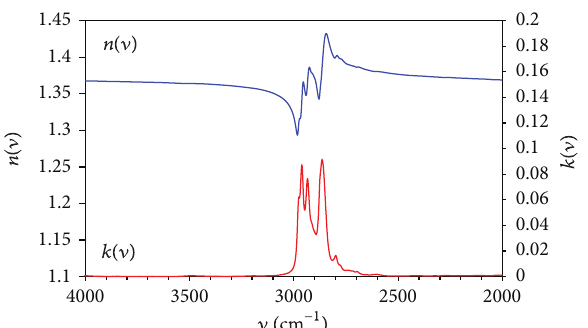
F 2: Spectrum of the complex refractive index of NBEE in the upper MIR range (4000–2000cm